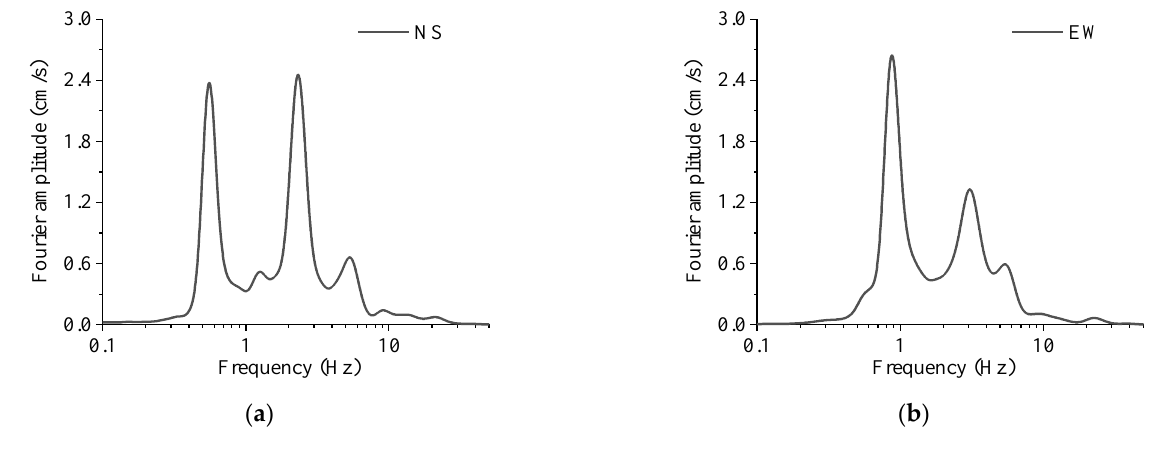
Figure 12. Fourier amplitude spectra of the structure in the NS and EW directions for structural response records ( a ) NS; ( b ) EW. Table 3. Natural vibration frequency values obtained from the structural response records (Unit: Hz).